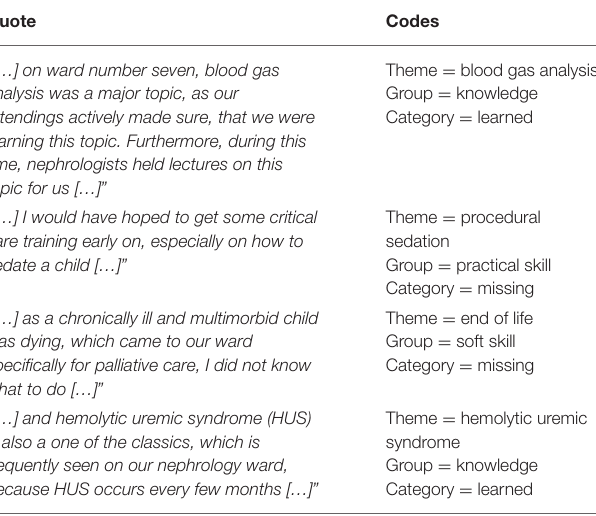
TABLE 1 | Coding examples of the qualitative thematic content